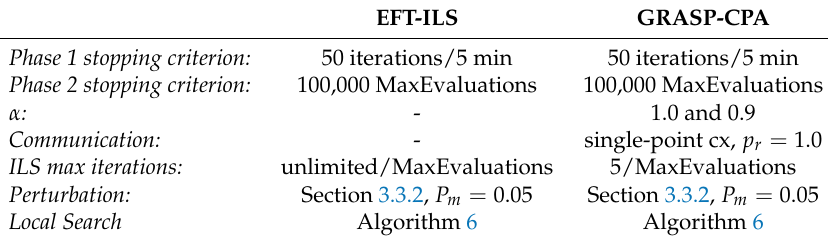
Table 3. Parameter settings for EFT-ILS and